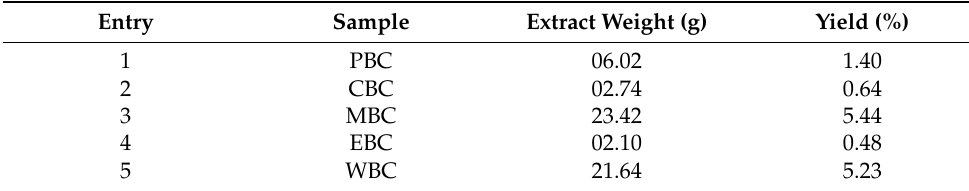
Table 1. Percentage yield of multi-solvent extracts of Bombax ceiba L.